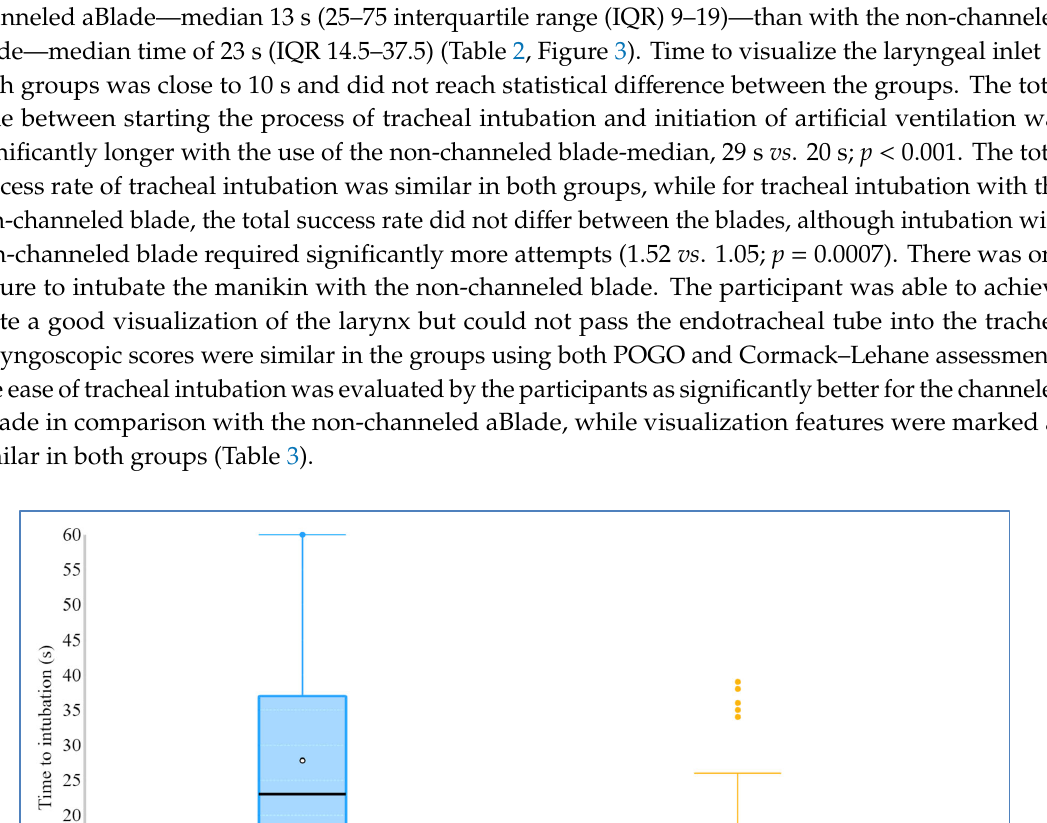
Table 2. Primary and secondary outcomes of the study.